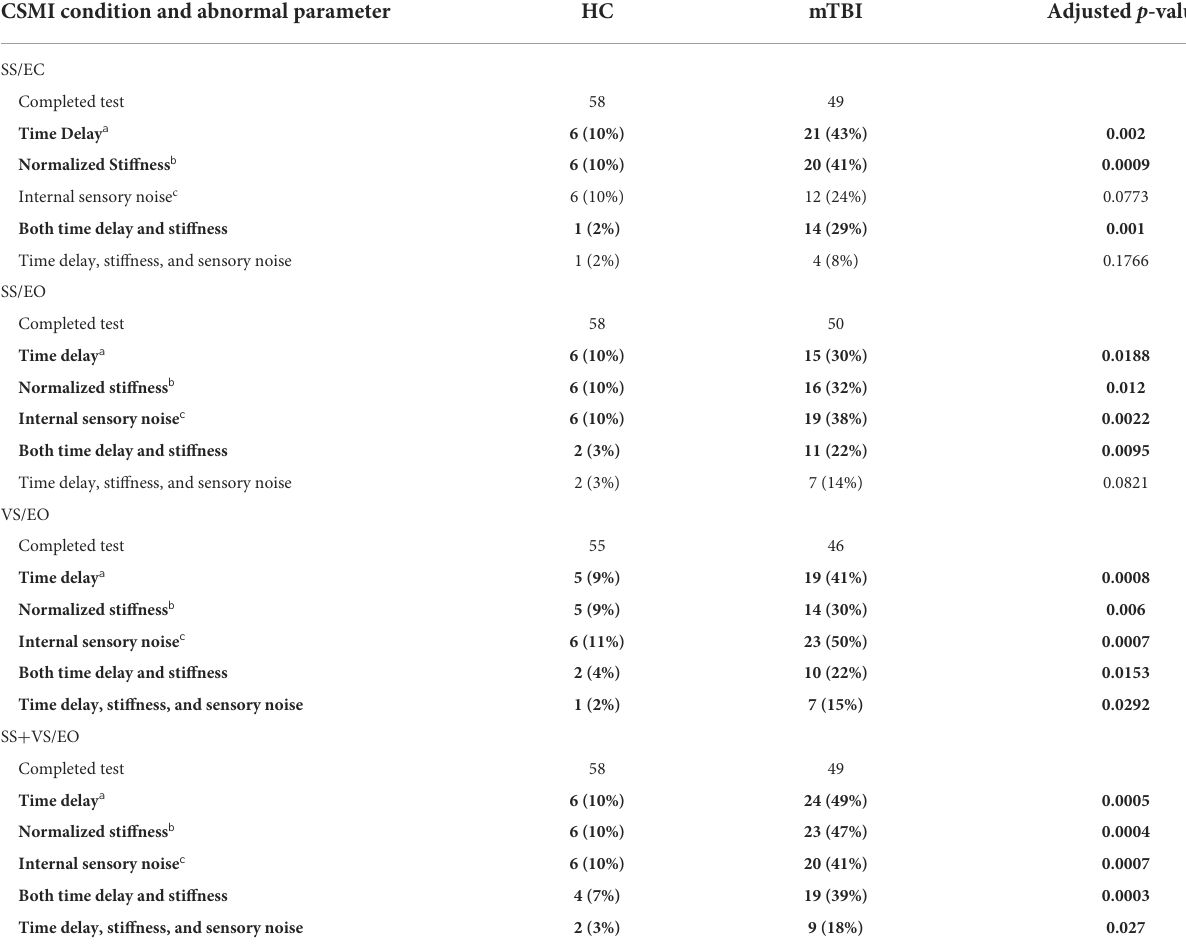
TABLE 5 Number (N) and percentage (%) of healthy control (HC) and chronic mTBI participants with abnormal Central Sensorimotor Integration (CSMI) time delay, normalized stiffness, internal sensory noise, and combinations of these measures. CSMI condition and abnormal parameter HC mTBI Adjusted p